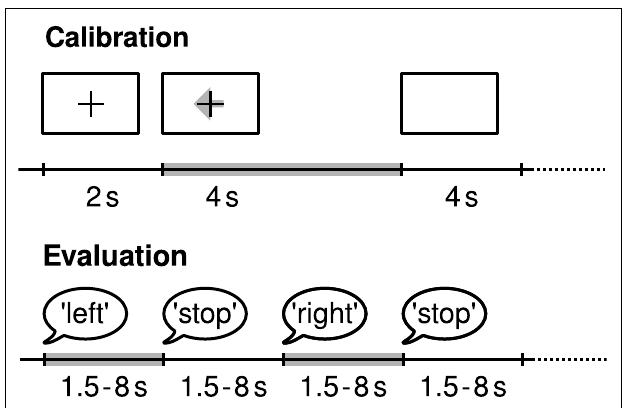
FIGURE 3 | (Data set 1 – trial structure). Training data was collected in the calibration runs. Arrows pointing left, right, or down have been presented as cues for imagining left hand , right hand , or foot movements. After a fixation cross was presented for 2s, the directional cue was overlaid for 4s.Then the screen was blank for 2s. In the test runs used for evaluation, spoken words have been presented as